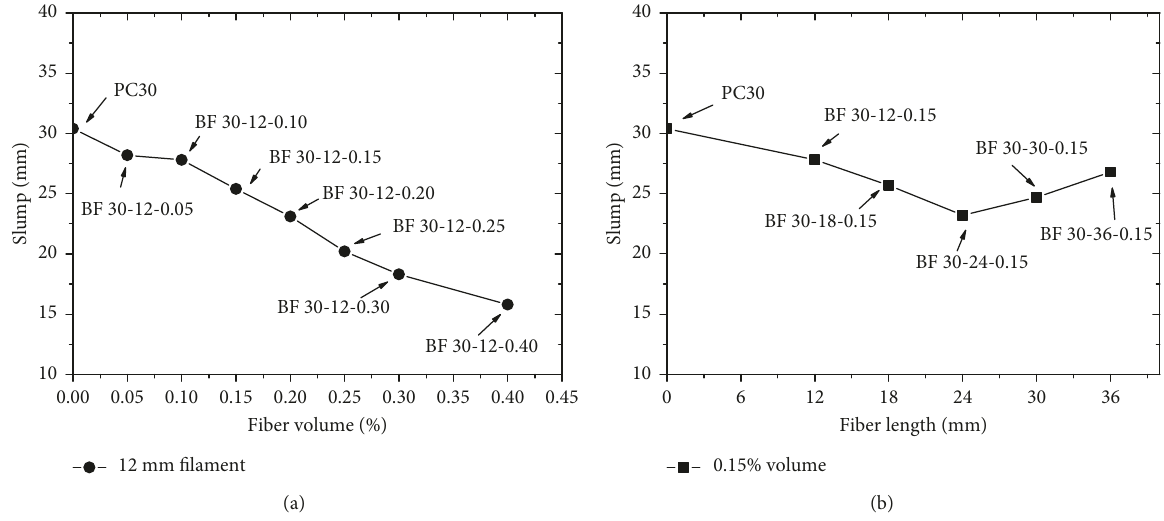
Figure 4: Effect of changing fiber volume fractions and fiber lengths on average slump values. (a) Slump change with different fiber volume fractions for specimens PC30 and BF 30-12-(0.05 ∼ 0.40). (b) Slump change with different fiber lengths for specimens PC30 and BF 30- (12 ∼ 36)-0.15.